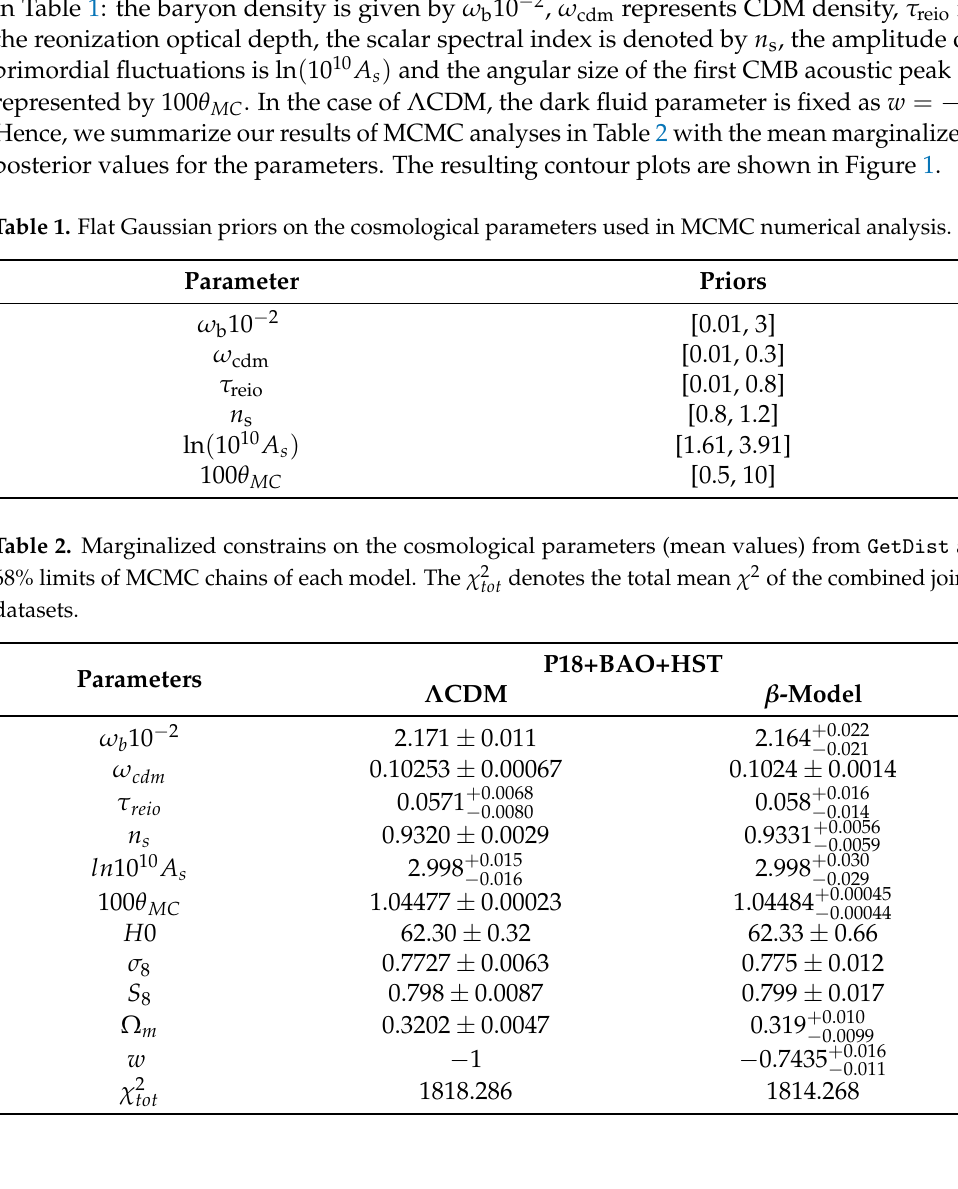
Table 1. Flat Gaussian priors on the cosmological parameters used in MCMC numerical analysis.